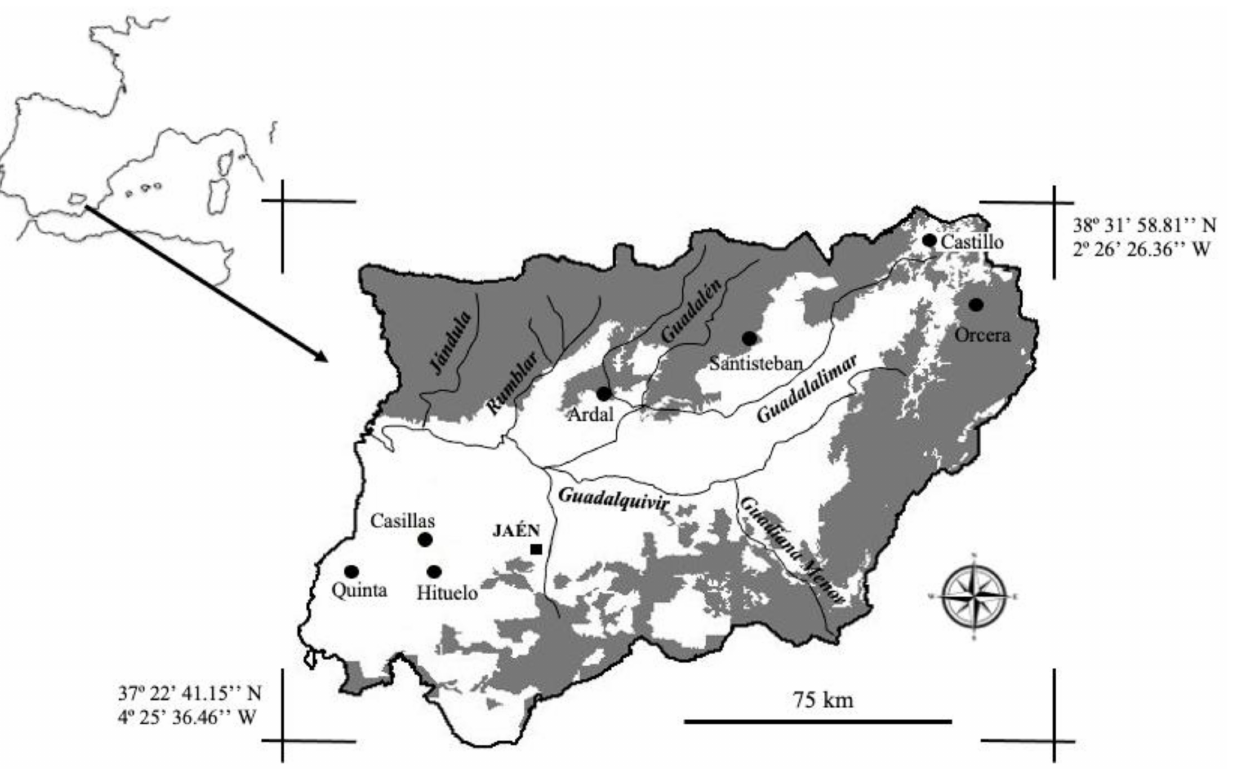
Figure 1. Distribution of the studied ponds in the Alto Guadalquivir region (Southeastern Spain).